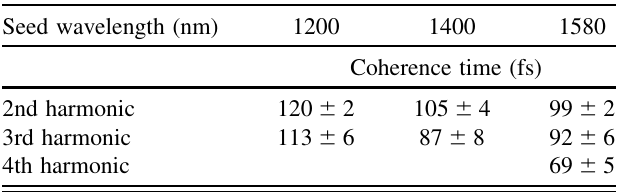
TABLE II. The coherence time for HGHG laser at different wavelengths of seed laser and different harmonics.